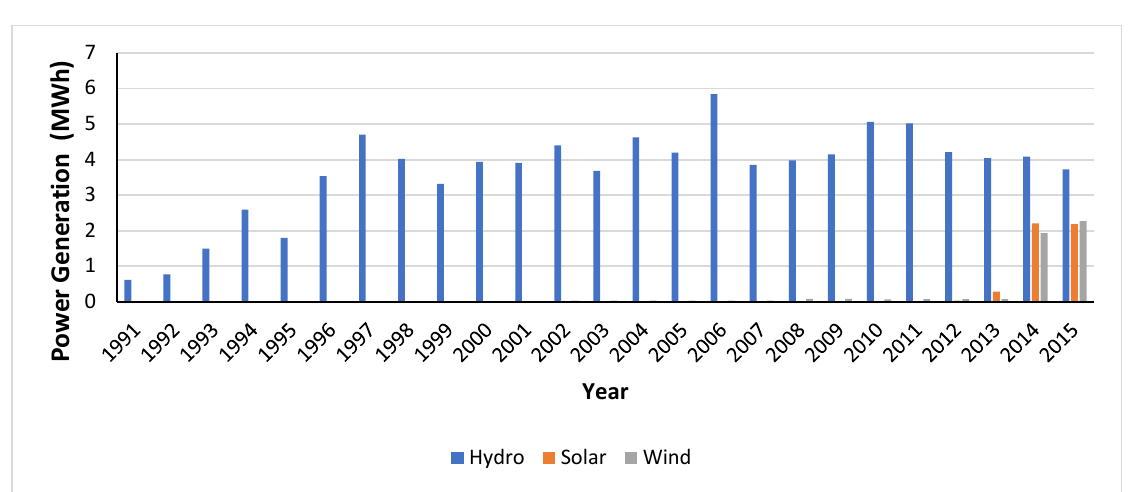
Figure 1. Power Generation from renewable sources from 1991 to